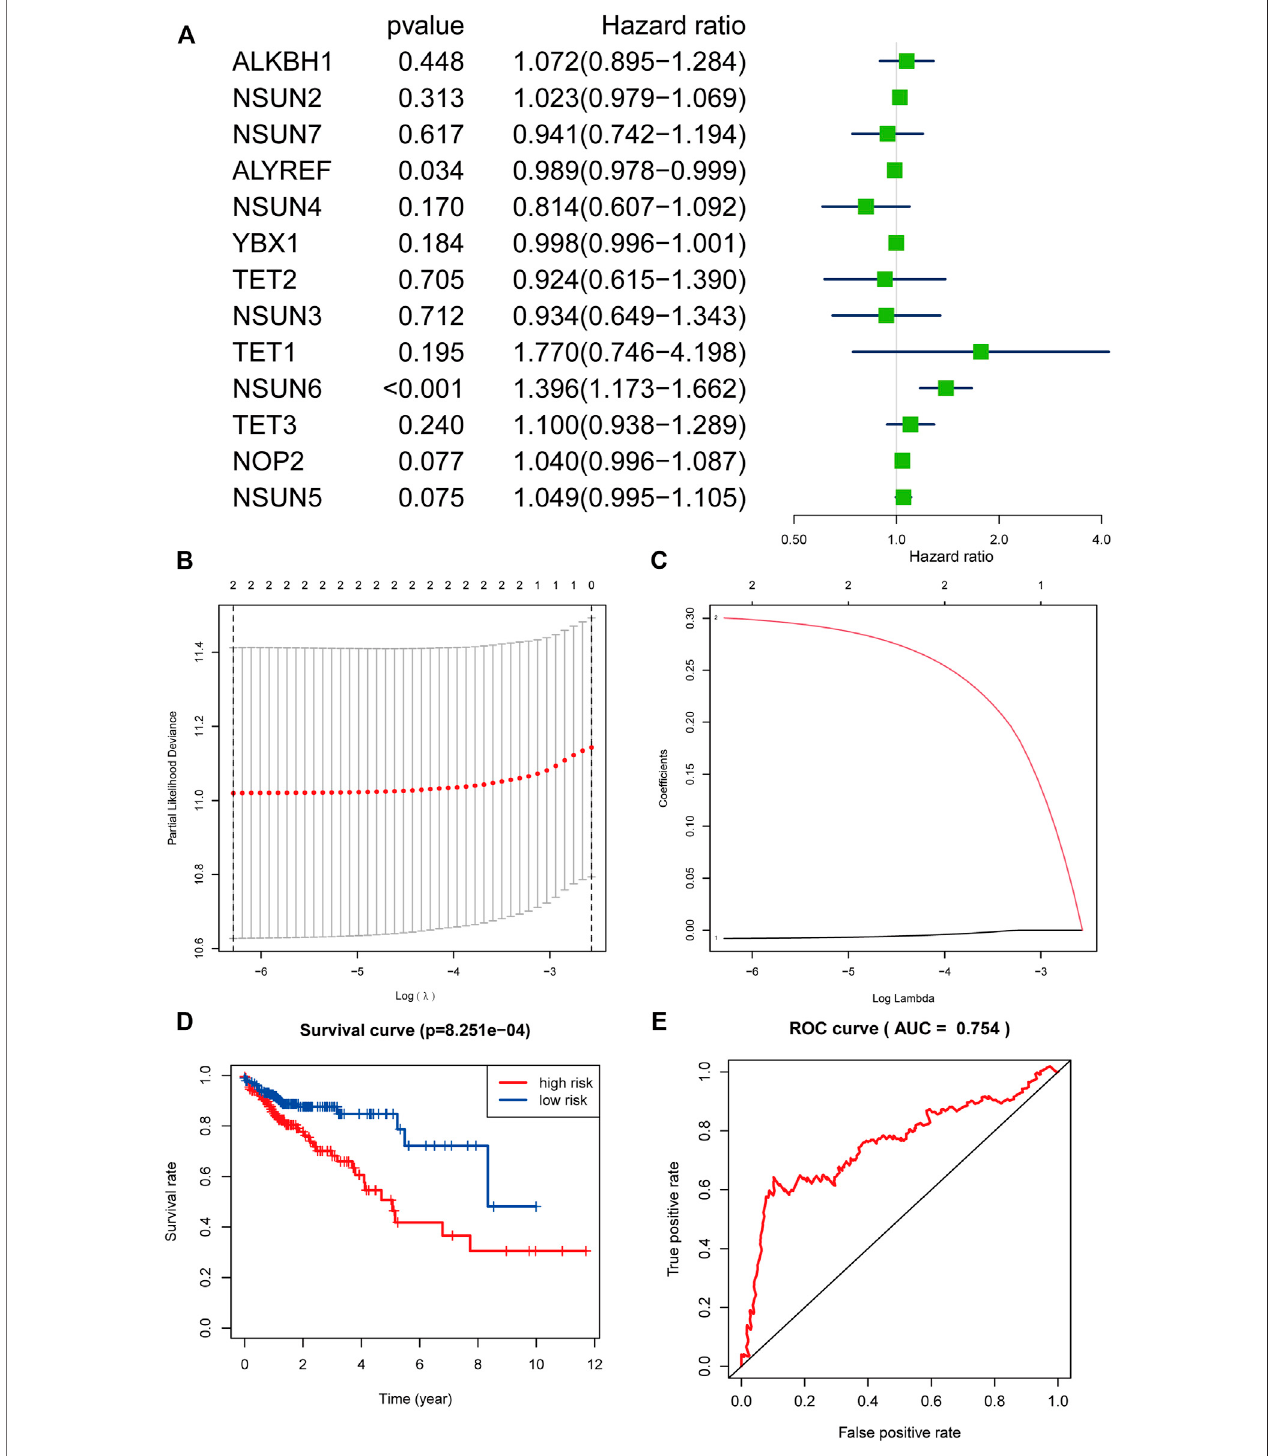
FIGURE 7 | The process of constructing the signature based on NSUN6 and ALYREF and evaluating its prognostic value. (A) The Hazard ratio (HR), 95% con fi dence interval (CI) of 13 m 5 C-related regulators estimated by univariate Cox regression. (B) The point with the smallest cross veri fi cation error corresponds to the number of factors included in the Lasso regression model. (C) The lines of different colors represent the trajectory of the correlation coef fi cient of different factors in the model with the increase of Log Lamda. (D) Kaplan-Meier overall survival curves for patients in high-risk group- and low-risk group divided according to the risk score. (E) ROC analysis and AUC value of the ROC curve suggested the sensitivity and speci fi city for risk signature.